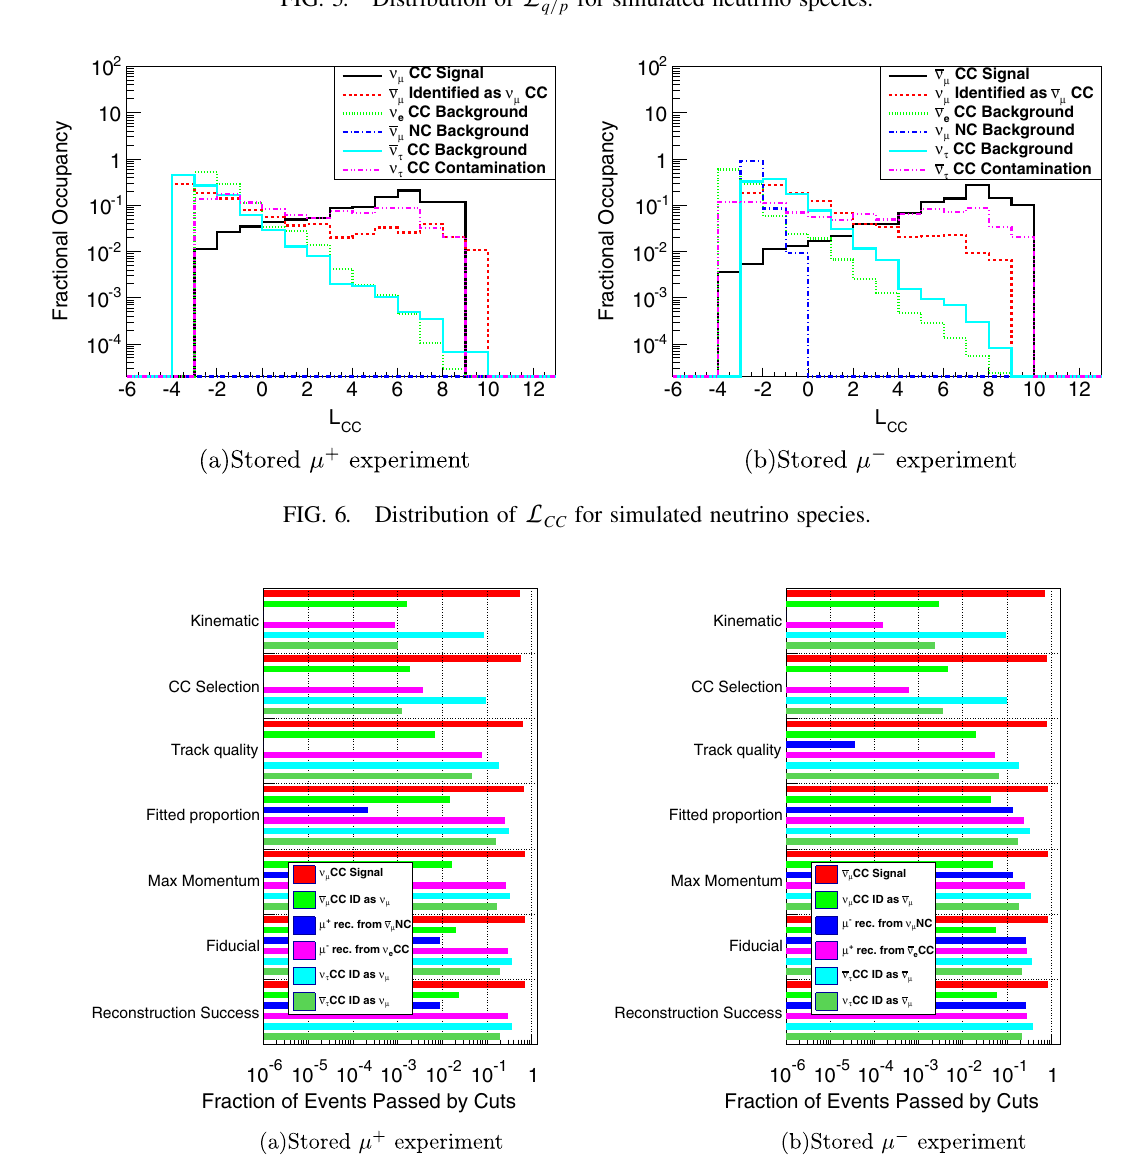
FIG. 5. Distribution of L q=p for simulated neutrino species.